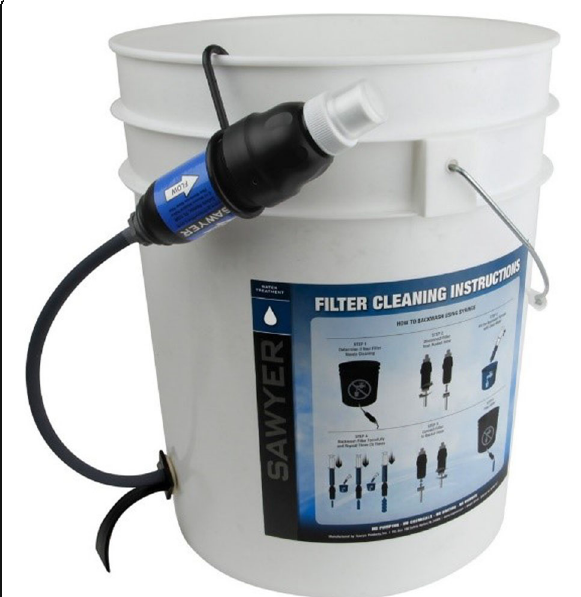
Fig. 1 An example of the Sawyer® PointONE ™ bucket filter system used in the study. The Sawyer® PointONETM bucket filter system consists of a 5-gallon bucket and filter attached with a hose. Water drains by gravity from the bucket, through the filter, and into a